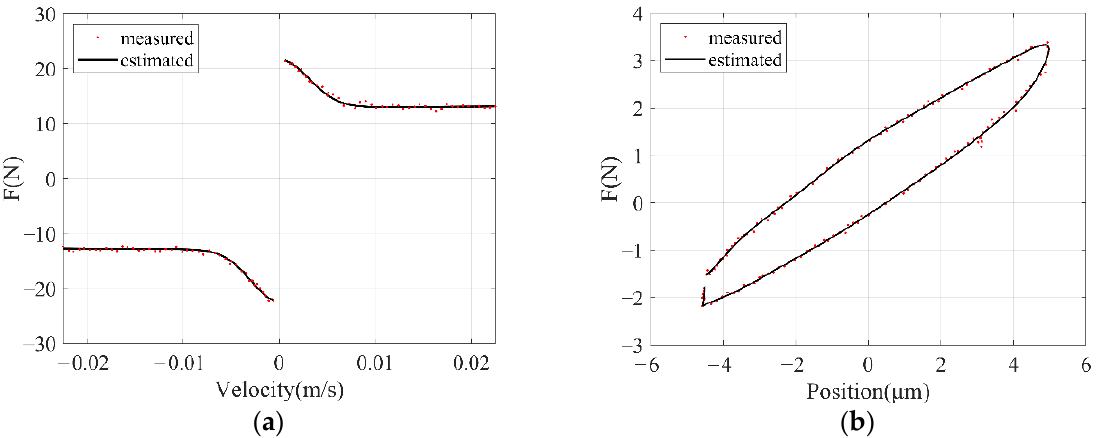
Figure 8. Friction characteristics of LM guides and identified feed drive model. ( a ) Stribeck curves. ( b ) Hysteresis curves. Table 5. Friction parameters identified in DDHLS.